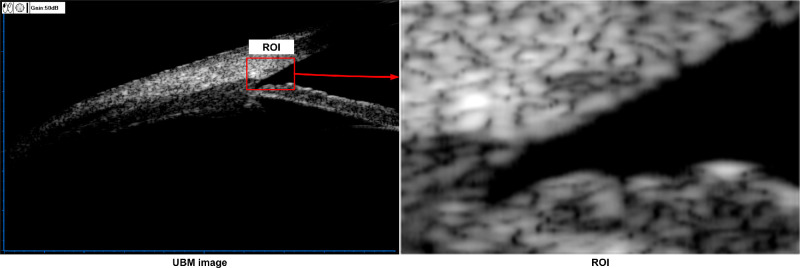
UBM image and ROI.